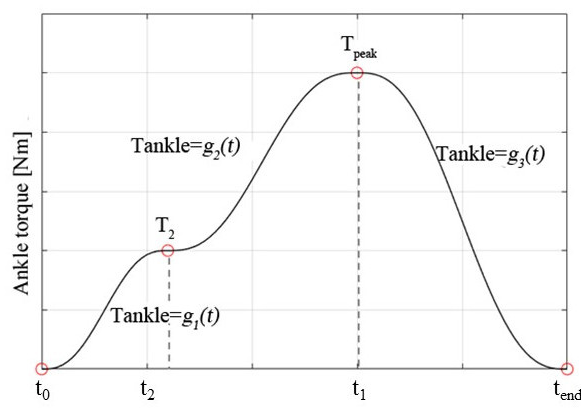
Figure 4. Ankle torque during the push-off phase.